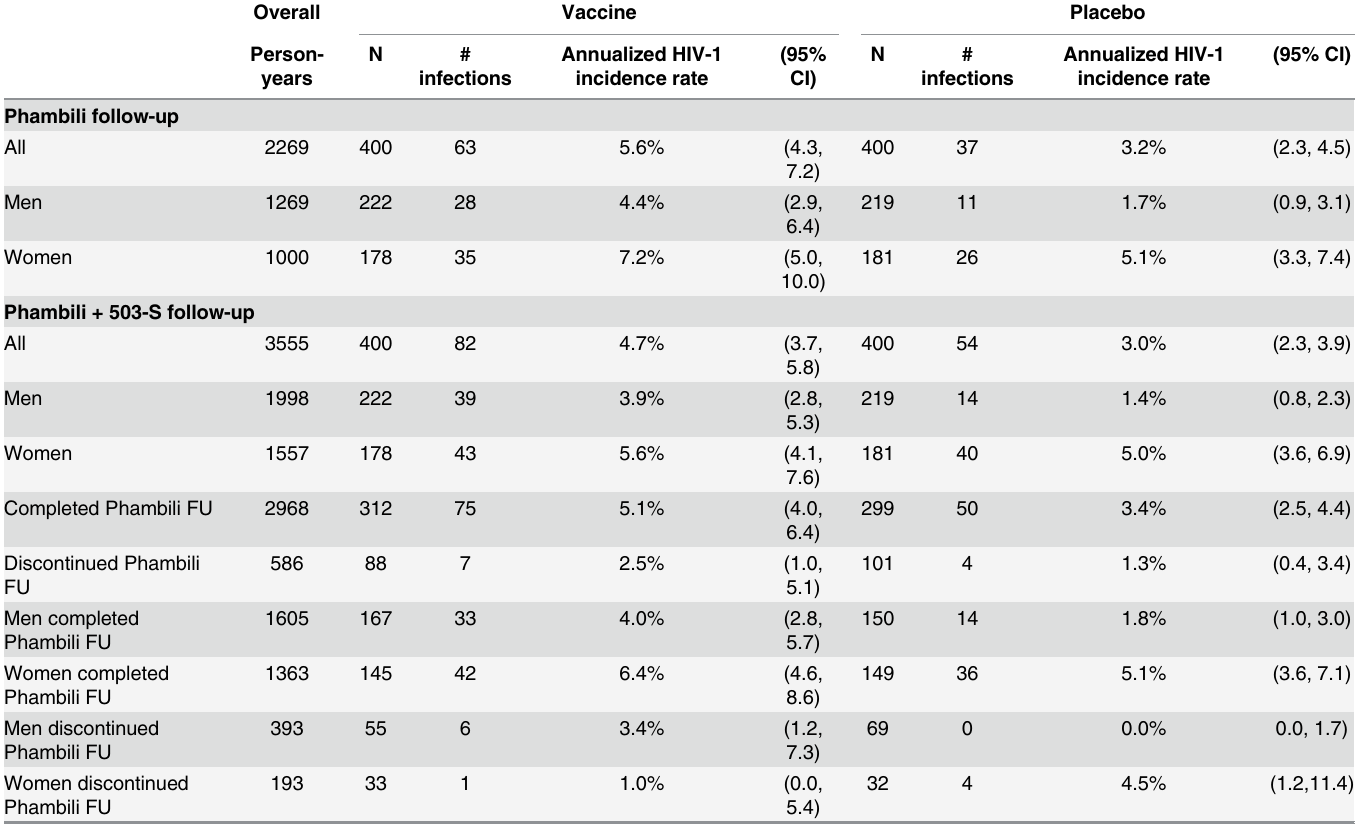
Table 2. Incident HIV-1 infections detected during Phambili and Phambili + HVTN 503-S follow-up